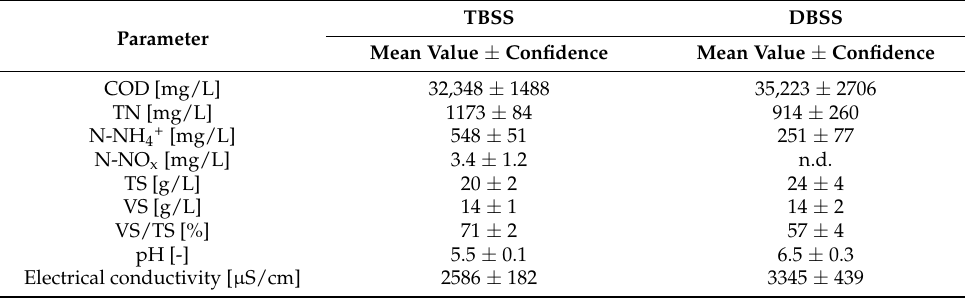
Table 1. Chemical and physico-chemical parameters of TBSS and DBSS.